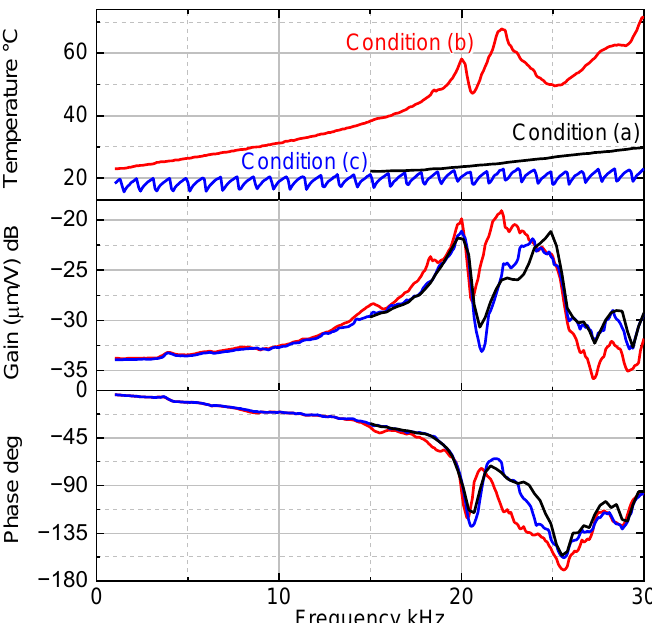
Figure 5. Measured frequency response (µm/V) of the PESA when a bias voltage of 50 V and sinusoidal voltage of 13 V were applied to the PESA with natural heat dissipation (red) and with forced liquid cooling (blue). The black line represents the frequency response with natural heat dissipation without sufficient time for the temperature to rise.